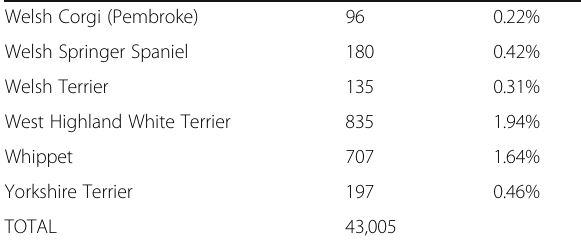
Table 1 Number of unique individual dogs for which responses